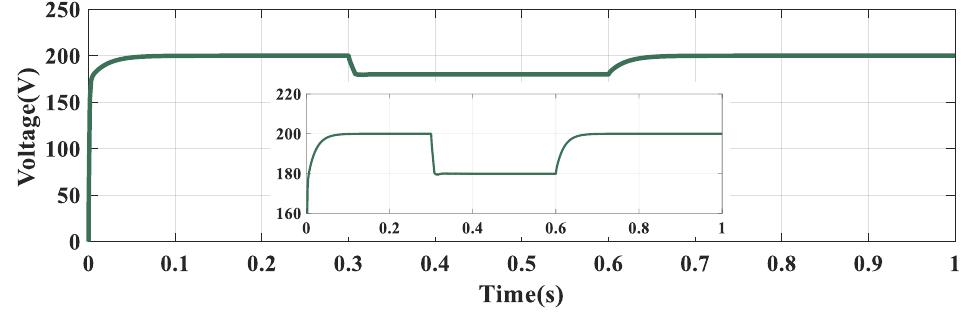
Figure 24. Study 4: load voltage.